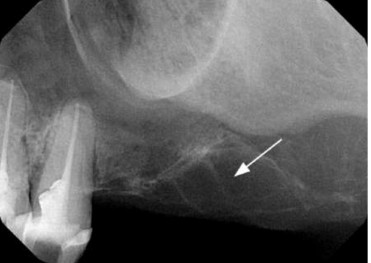
Figure 3. Periapical X-ray of the upper left molar region with the lesion of the processus alveolaris in the molar